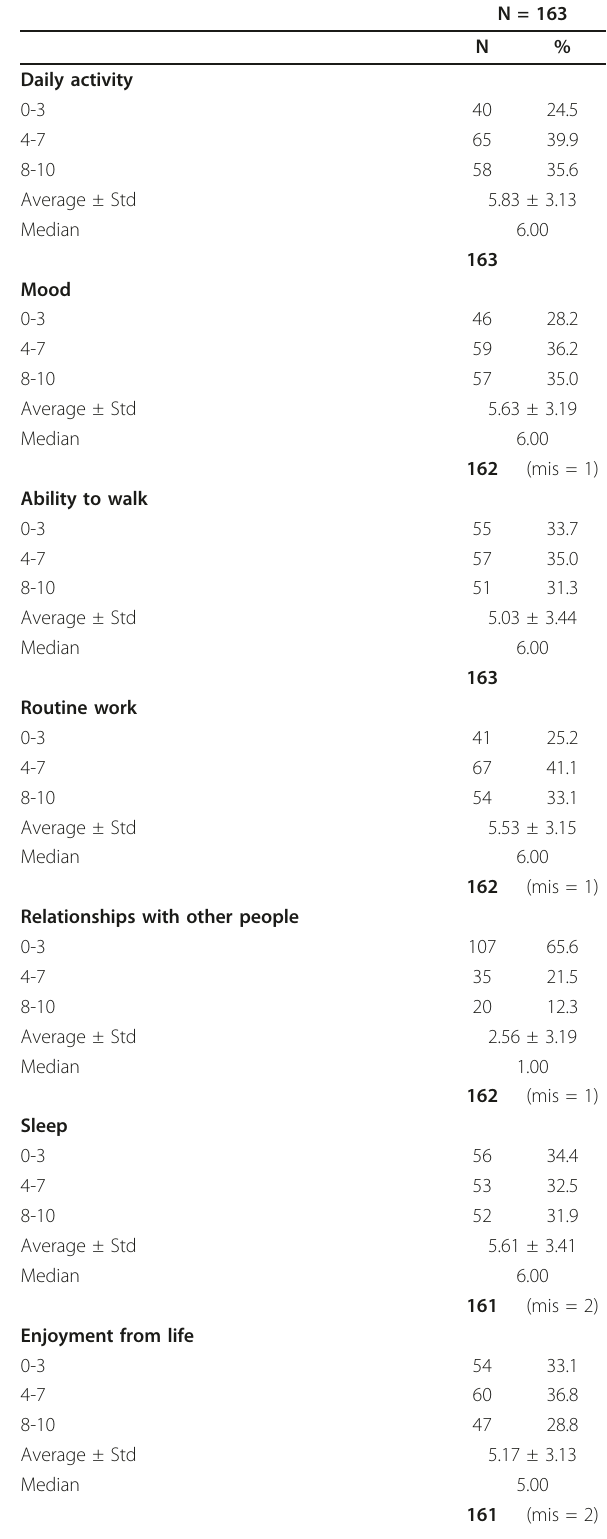
Table 3 Pain influence on daily routine (scale of 0-10: 0-no disturbance; 10-highest disturbance)